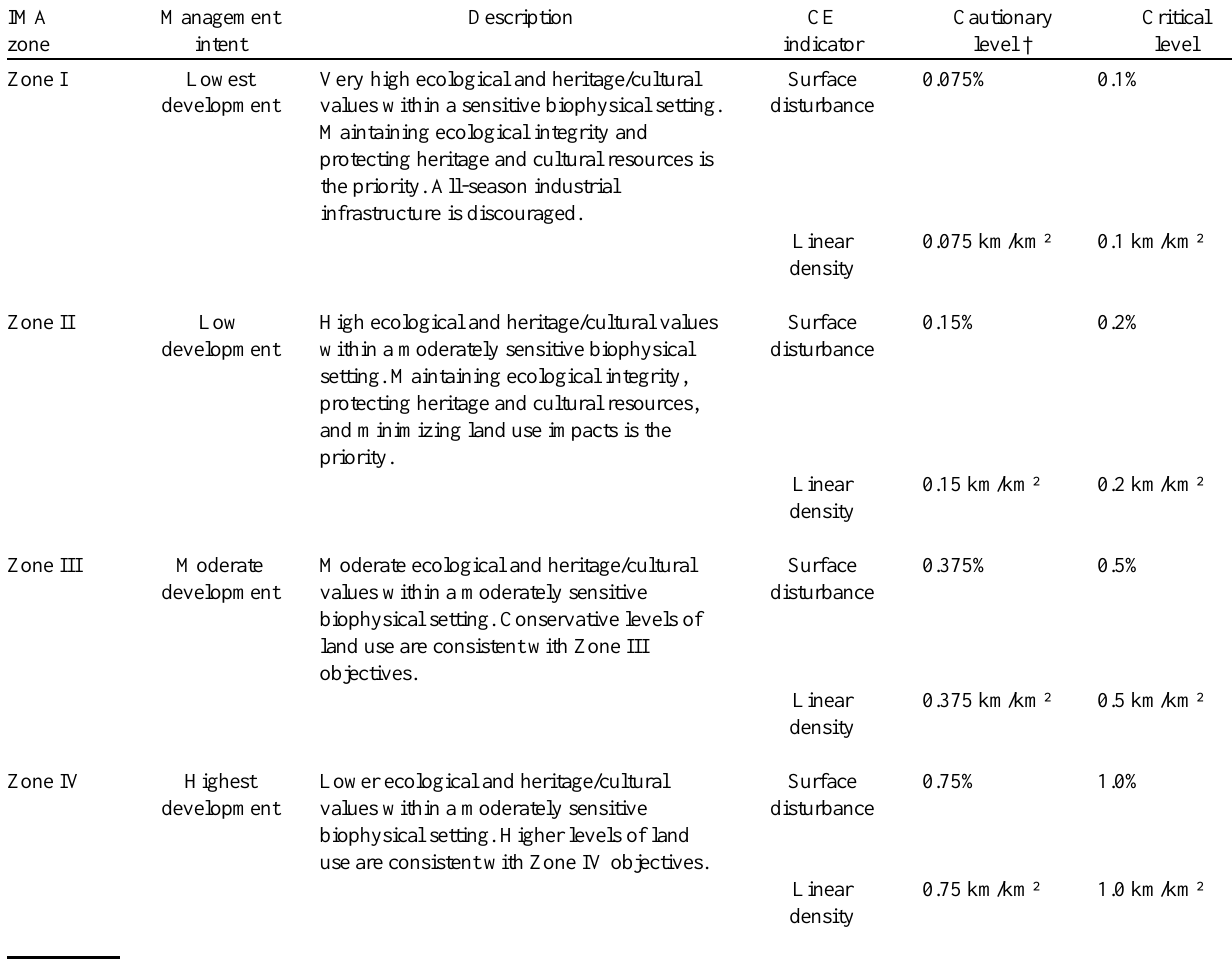
Table 1 . North Yukon Regional Land Use Plan integrated management area (IMA) zoning system and recommended